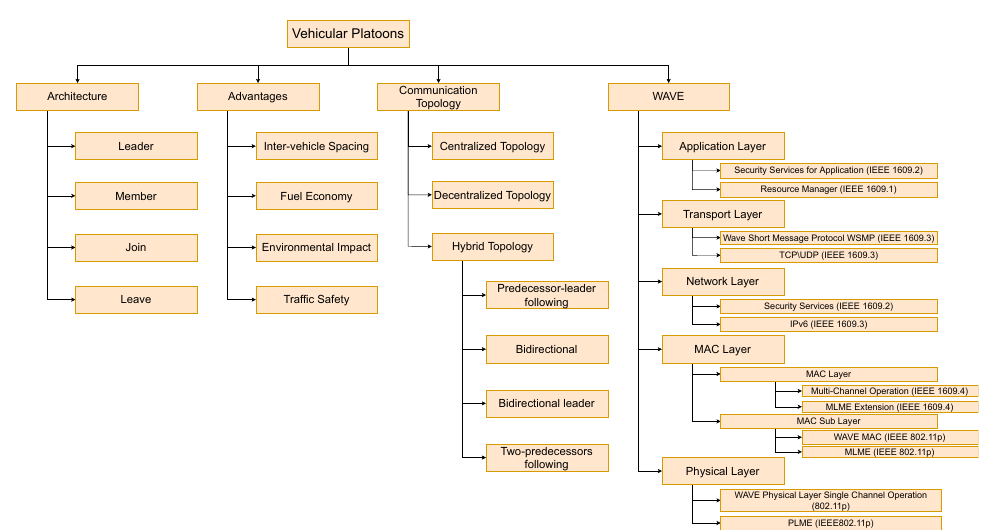
Figure 11. A detailed taxonomy of Vehicular